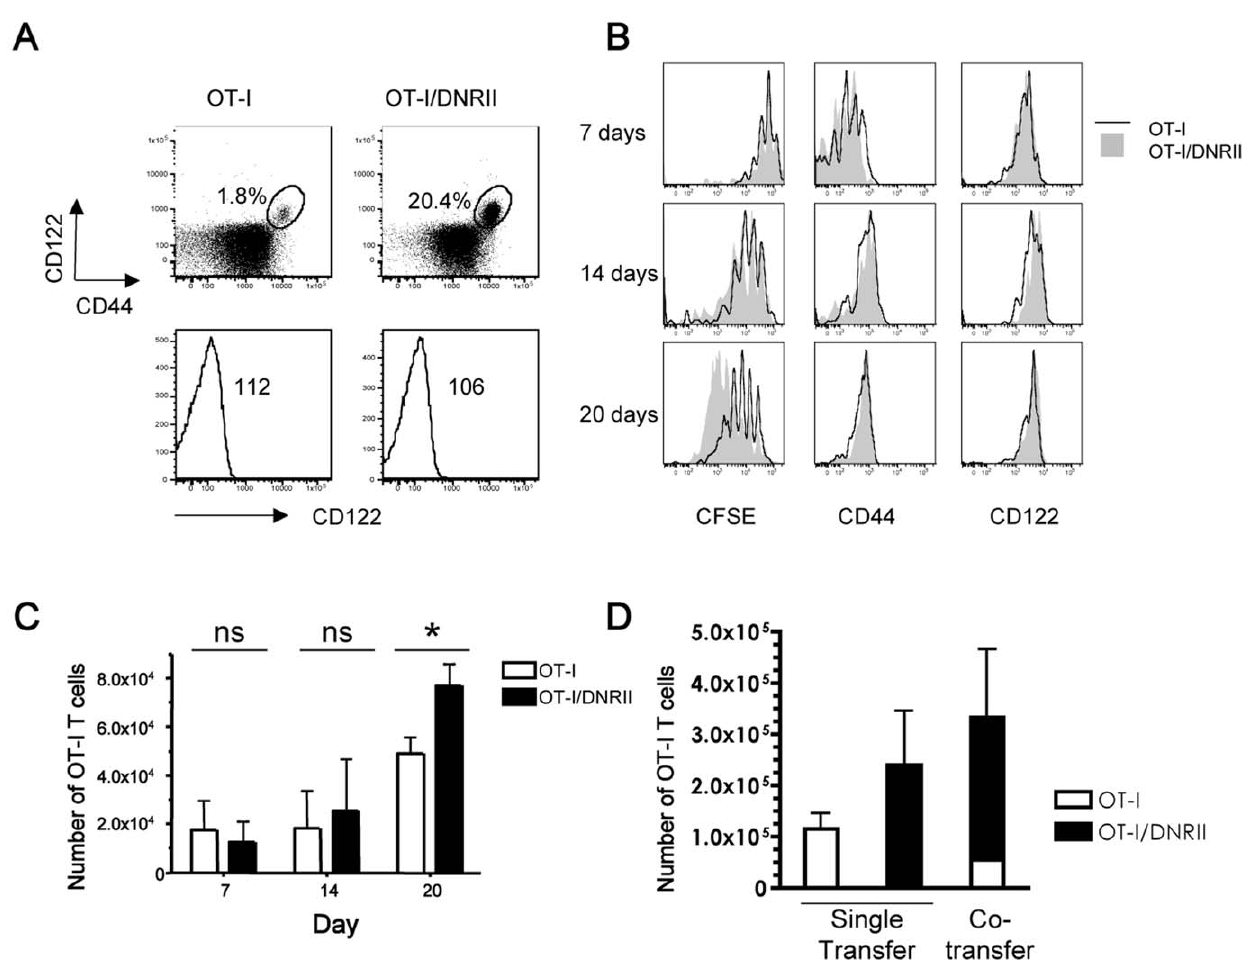
Figure 1. Attenuated TGF- b sensitivity alters homeostasis of OT-I CD8 T cells. (A) Analysis of intact OT-I and OT-I/DNRII mice. Spleen and lymph node cells from OT-I/DNRII mice exhibit an elevated frequency of CD44 hi CD122 hi CD8 + T cells compared to normal OT-I controls (upper panels, gated on CD8 + Kb-OVA + ). The percentage of CD44 hi CD122 hi is indicated in each dot plot. CD122 express within the CD44 lo population is equivalent in OT-I and OT-I/DNRII (lower panels, gated on CD8 + Kb-OVA + CD44 lo . (B) CFSE labeled CD44 lo OT-I or OT-I/DNRII TCD8 cells were adoptively transferred into sublethally irradiated B6 recipients. Host animals were sacrificed at the indicated timepoints and donor cells analyzed. Expression of CFSE, CD44 and CD122 levels on donor OT-I or OT-I/DNRII cells recovered from the spleen at 7, 14, and 20 days after transfer. (C) Mean number of splenic OT-I and OT-I/DNRII cells recovered from the spleen of host animals (n=3 per group). (D) The mean number of donor cells recovered from single or cotransfer of OT-I and OT-I/DNRII CD8 T cells in the lymph nodes 18 days after transfer into sublethally irradiated B6 (n=3 per group). All data are representative of at least 3 independent experiments.